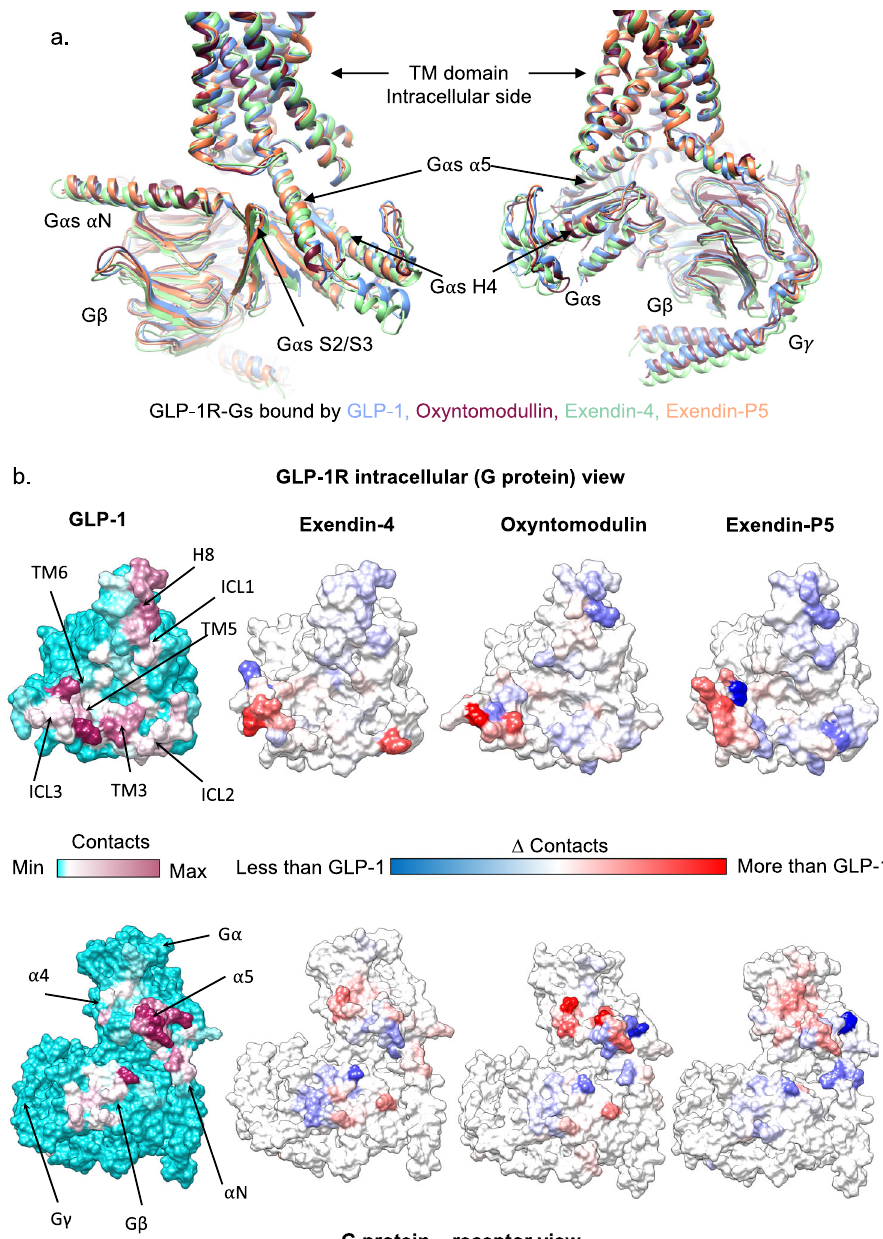
Fig. 8 Interaction of G s with the GLP-1R in the presence of different peptide agonists. a Superimposition of GLP-1R:G s structures bound with GLP-1 (PDB – 6X18, blue), exendin-4 (pale green), oxyntomodulin (dark pink) and exendin-P5 (pale orange) (PDB - 6B3J), viewing the GLP-1R interface. b Contact differences between the four complexes plotted on the receptor (top) and G s (bottom) surface determined from MD simulations. The fi rst column shows the contacts between GLP-1R (top) and G s (bottom) during the MD simulations in the presence of GLP-1, with no contacts in cyan and increasing contacts heat mapped from white to dark pink. The other three columns report the contact differences (relative to GLP-1) for each residue of the GLP-1R and G s during the MD performed in the presence of the other agonists with blue indicating fewer contacts, white similar contacts, and red enhanced